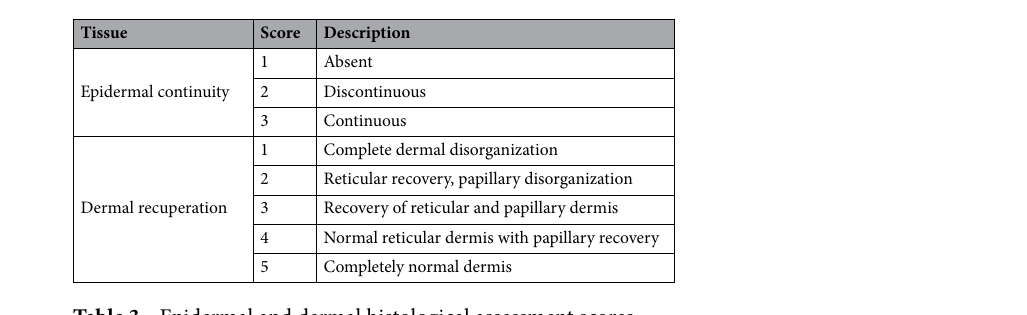
Table 3. Epidermal and dermal histological assessment